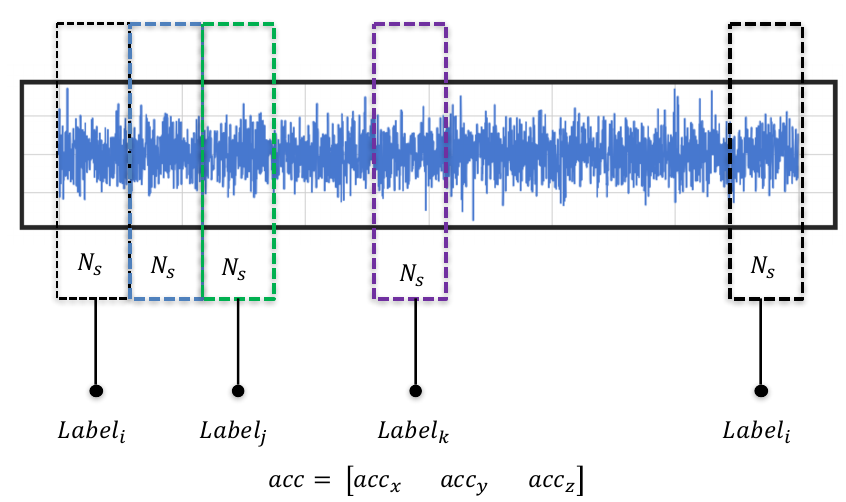
Figure 4. A typical time-sliced preprocessing of raw